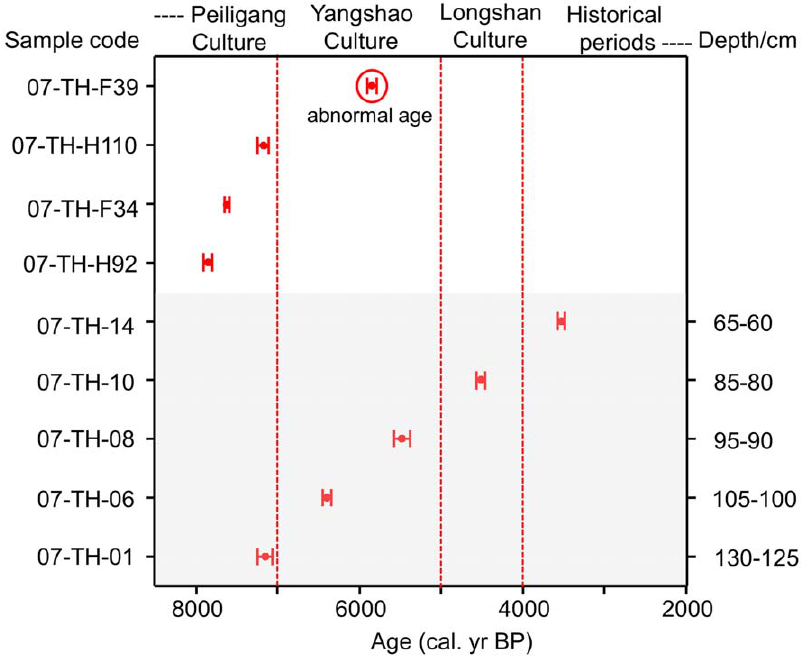
Figure 3. AMS 14 C ages from the Tanghu site. 07-TH-01, 06, 08, 10, 14 collected from the profile; 07-TH-H92, H110 collected from pits H92 and H110; 07-TH-F34, F39 collected from houses F34 and F39. 14 C ages made by Guangzhou Institute of Geochemistry, CAS, and the State Key Laboratory of Nuclear Physics and Technology of Peking University. CalPal was used to calibrate the data [59,60]. Dated materials are paleosoil rich in charcoal.